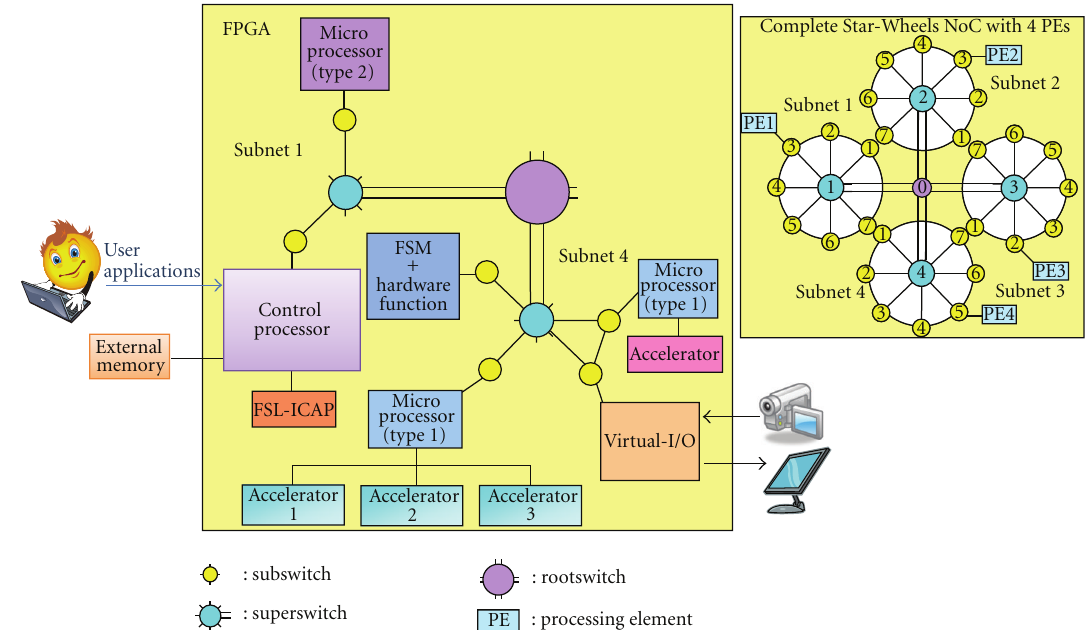
Figure 1: Example RAMPSoC system at one point in time connected over the Star-Wheels